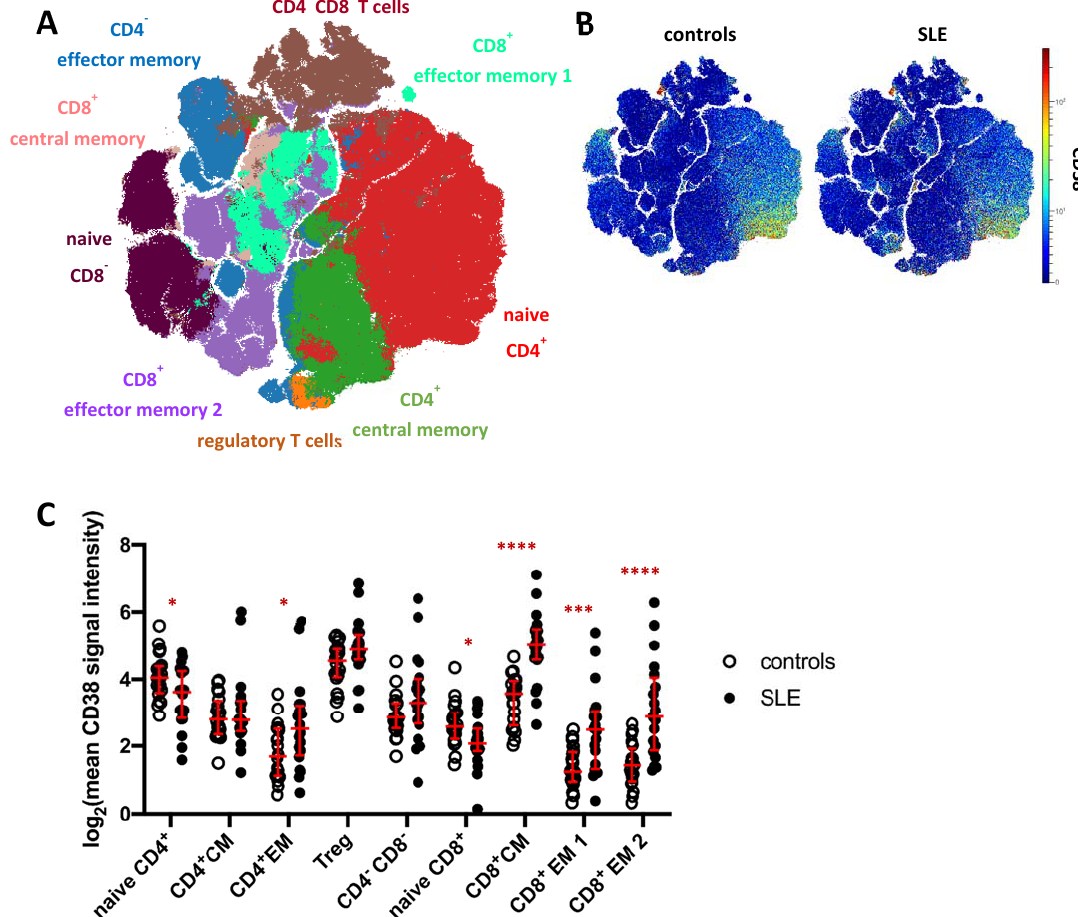
Figure 3. CD38 expression across T cell subsets in patients with SLE. ( A ) t-SNE map showing T cell clusters obtained by FlowSOM clustering from the mass cytometry dataset. Major T cell subsets are annotated. Clusters comprising CD4 ‐ CD8 ‐ T cells (brown), CD4 + effector memory T cells (blue), and CD8 + effector memory subsets (turquoise) were merged for downstream analyses (Supplementary Figure S4A). ( B ) CD38 expression across T cells in SLE patients and controls. ( C ) T cell clusters depicted in ( A ) were analyzed for their CD38 expression. Each dot represents the log 2 of mean CD38 signal intensity (SI) of the indicated subset of one donor. Red lines indicate medians and interquartile ranges. * indicates significantly different CD38 expression in SLE patients vs. controls revealed by Mann–Whitney testing (* p < 0.05; ** p < 0.01; *** p < 0.001; **** p < 0.0001).